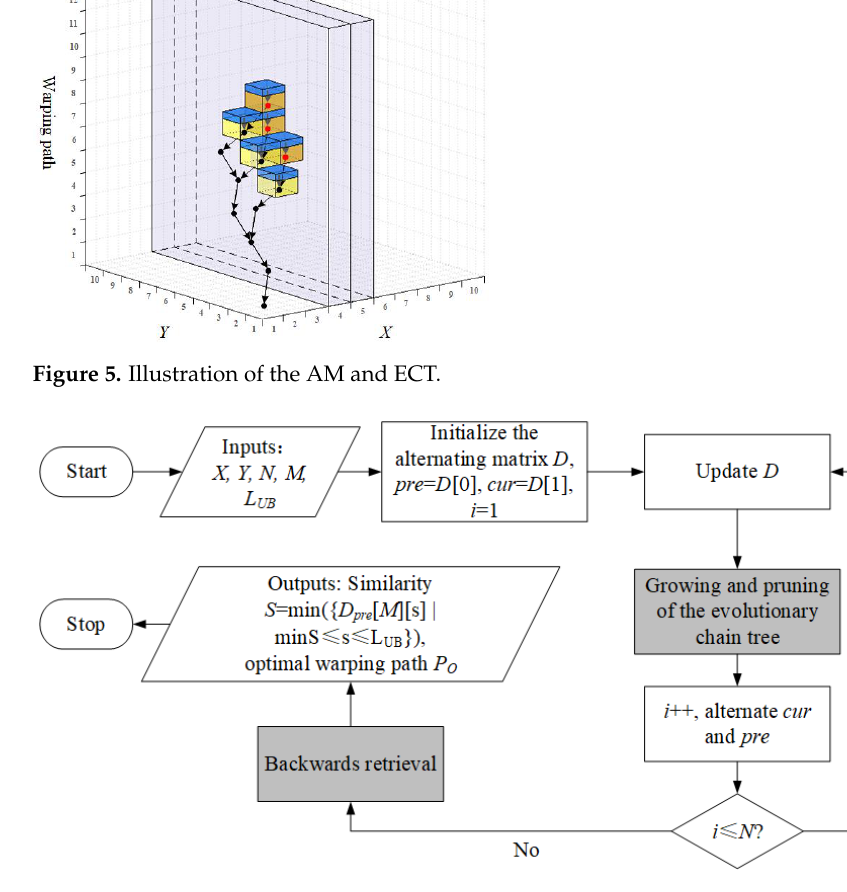
Figure 5. Illustration of the AM and ECT.